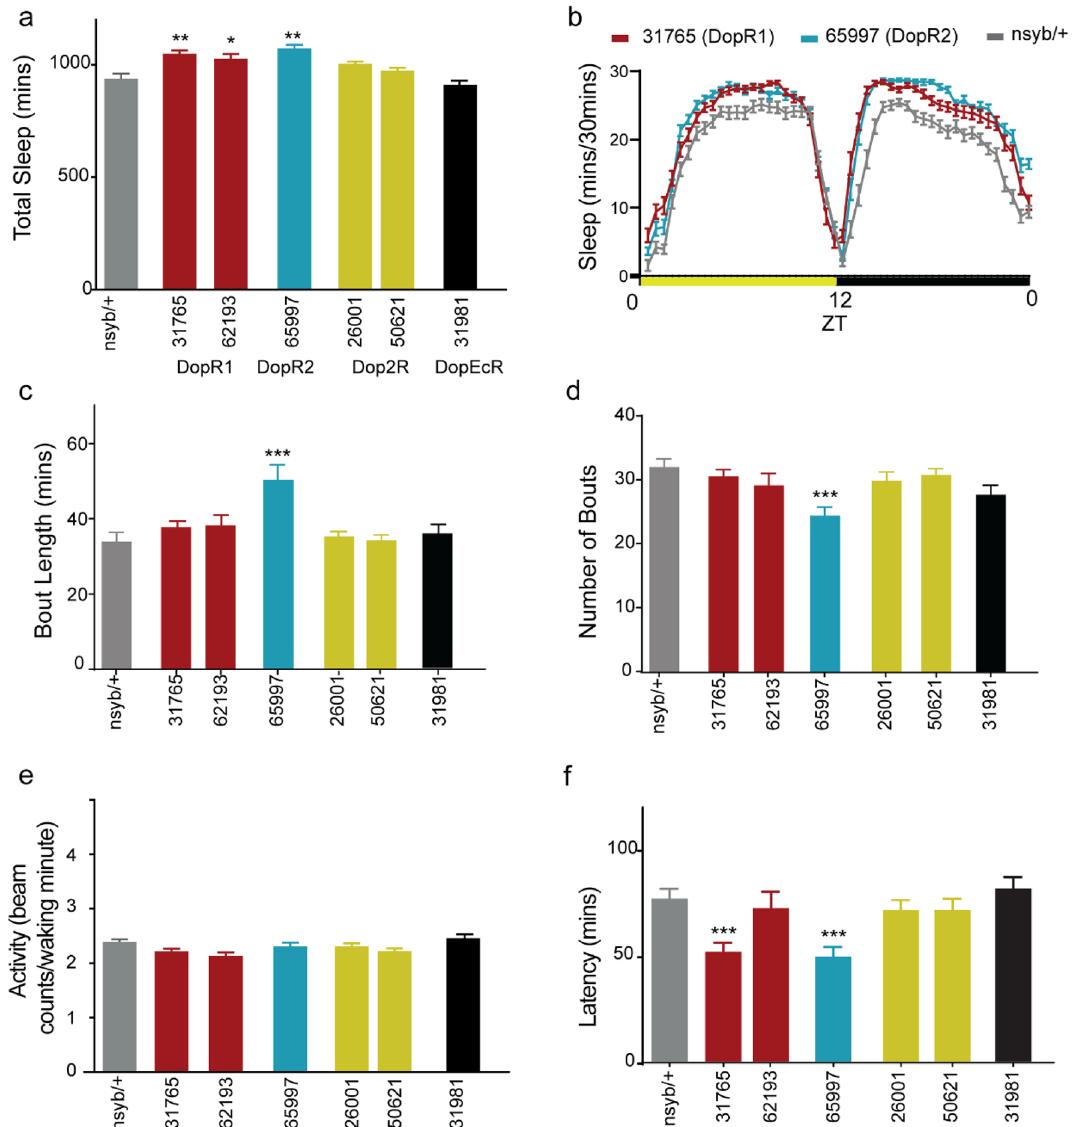
Figure 5. Pan-neuronal knockdown of dopamine receptors DopR1 and DopR2 increases sleep amount without altering waking activity. ( a ) Total sleep or sleep duration over 24 h in flies expressing validated UAS-RNAi lines targeting dopamine receptors specifically: DopR1 (31765, and 62193-red), DopR2 (65997-blue), Dop2R (2 lines: 26001 and 50621-yellow) and DopEcR (31981-black) pan-neuronally using nsyb-GAL4. Sleep data represents 2-day average (Day 3 and 4) at 24 ο C after 2-day entrainment. nsyb-GAL4/+ flies (grey bars) were used as a negative control. ( b ) Representative sleep profile of RNAi mediated depletion of DopR1 (red) and DopR2 (blue) receptors in nsyb-GAL4 and control nsyb/+ (grey). ZT indicates zeitgeber time where ZT 0: lights on and ZT 12: lights off. ( c , d ) Average bout length and number of bouts. ( e ) Activity or average beam crossings/waking minute indicative of locomotor activity of all tested genotypes. ( f ) Sleep latency or time to sleep was calculated as the time gap between lights off and first sleep bout. Latency was reduced in nsyb/DopR1-RNAi (31765) and nsyb/DopR2-RNAi 65997) flies as compared to nsyb/+. For each of the experimental groups tested we had 88–98 flies which represented 4 independent experimental trials, sample included nsyb/+ (95), nsyb/31765 (96), nsyb/62193 (98), nsyb/65997 (93), nsyb/26001 (96), nsyb/50621 (96), and nsyb/31981 (88). Data represents mean and SEM, * indicates p < 0.05, ** indicates p < 0.001 and *** indicates p < 0.0001. Statistical analysis was one-way ANOVA and Dunnett’s paired comparison with control for ( a , e , f ) and Kruskal–Wallis non-parametric one-way ANOVA and Dunn’s post-hoc correction for ( c , d